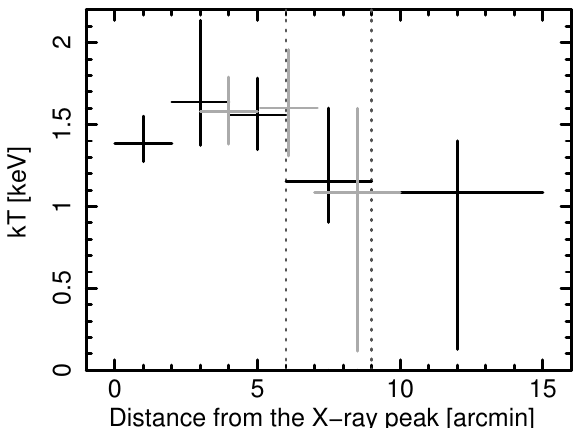
Figure 4. The temperature profile of the RXC J1053.7+5453 across the relic from [7]. The horizontal axis represents the angular distance from the X-ray peak. The inner and outer edge positions of the relic are displayed in dotted lines. Black and light gray crosses show the results from green and yellow regions in Figure 3, respectively.